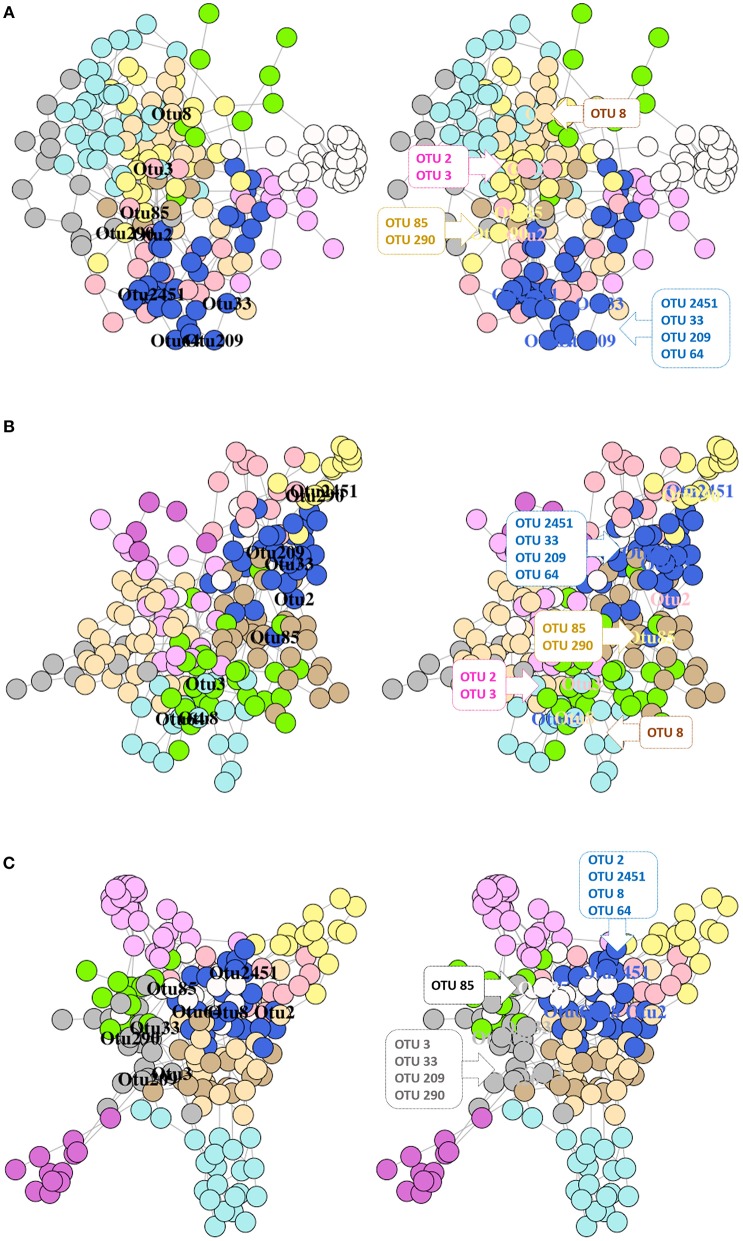
Network graphs showing the significantly abundant and relevant OTUs of the intestinal content in different modules of the network. Bacterial networks of the control (A), RII (B), and RIII (C) fish. Nodes represent OTUs and specific colors of the modules reveal the membership of the significantly abundant and relevant OTUs. The left graph shows the location of the OTUs and in the right graph, the significantly abundant and relevant OTUs that belong to the same module are shown in callouts.